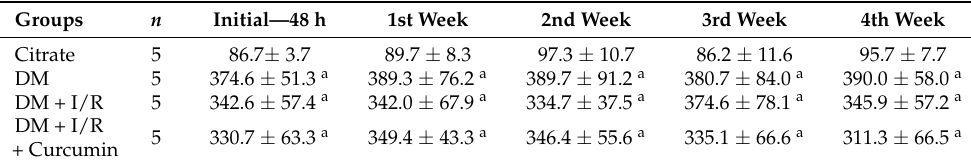
Table 1. Monitoring of blood glucose.